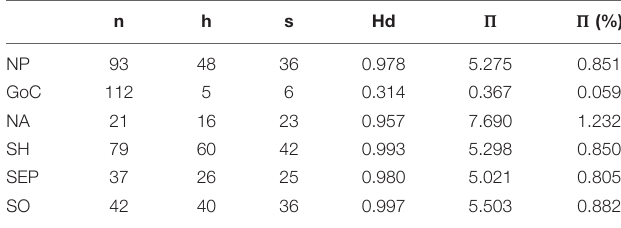
TABLE 1 | Genetic diversity of fin whale populations by geographic origin: NP, North Pacific; GoC, Gulf of California; NA, North Atlantic; Southern Hemisphere [SH = southeastern Pacific (SEP) + Southern Ocean